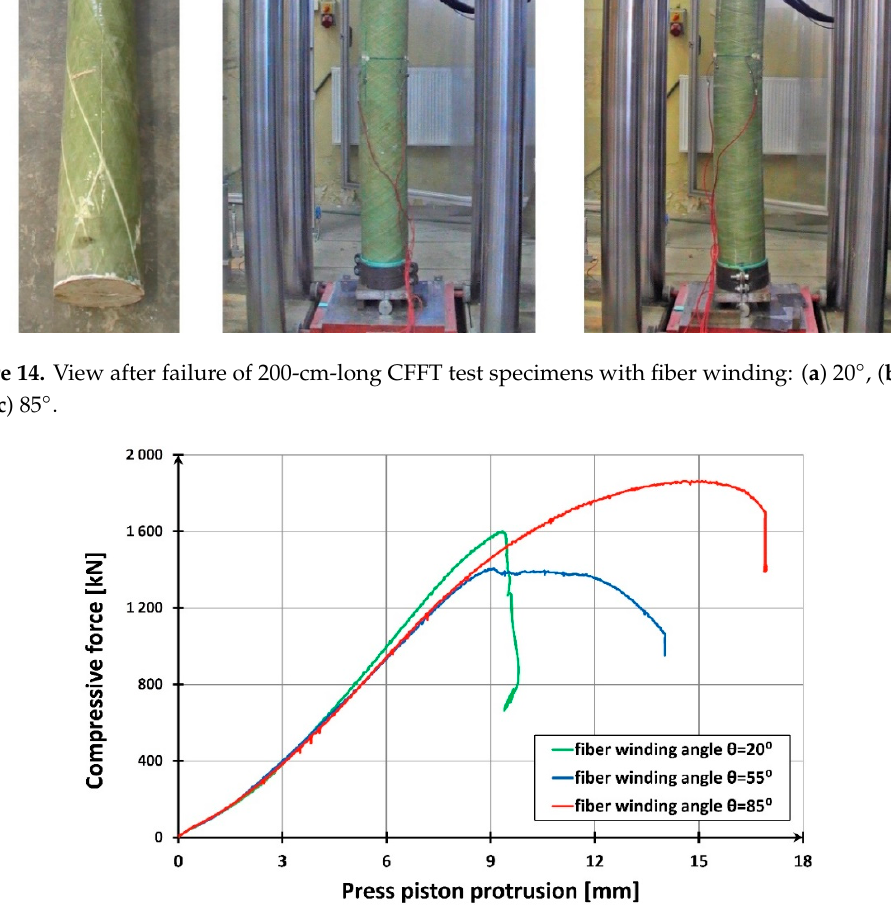
Figure 15. Force-displacement relation for test specimens made of 200-cm-long composite pipe filled with concrete. Table 6. Failure forces obtained for long CFFT columns depending on the angle of glass fiber winding of the composite pipe.